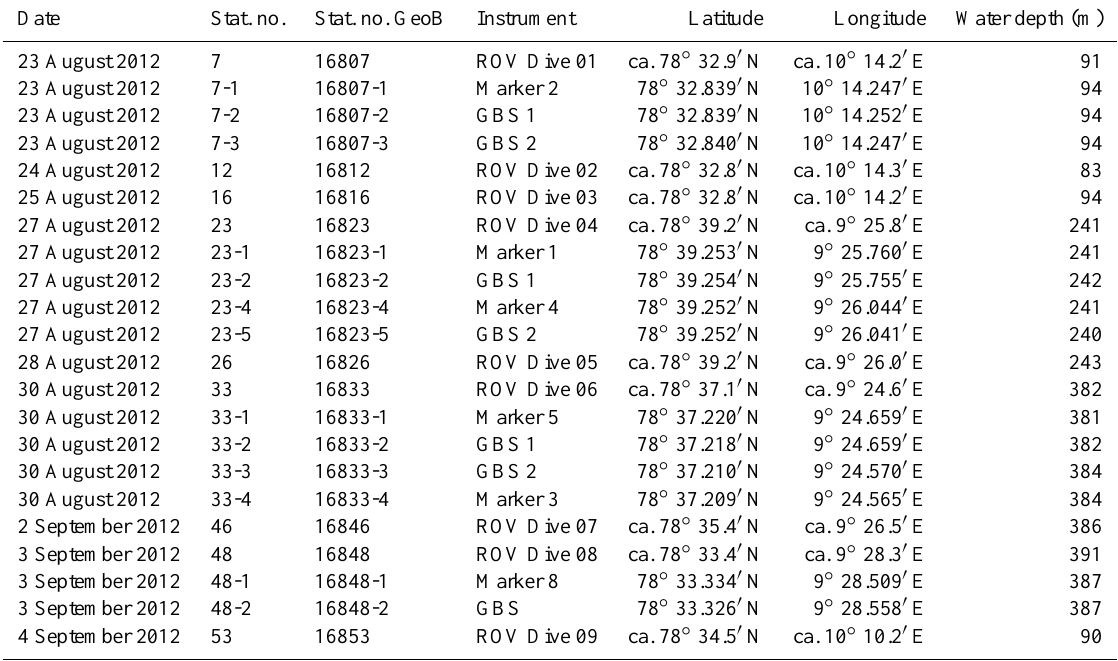
Table 1. Stations and instruments deployed during R/V Heincke cruise He-387. Abbreviations: ROV, MARUM’s remotely operated vehicle Cherokee; GBS, gas bubble sampler; Marker, seafloor-deployed stone with a syntactic floating foam bound to it.